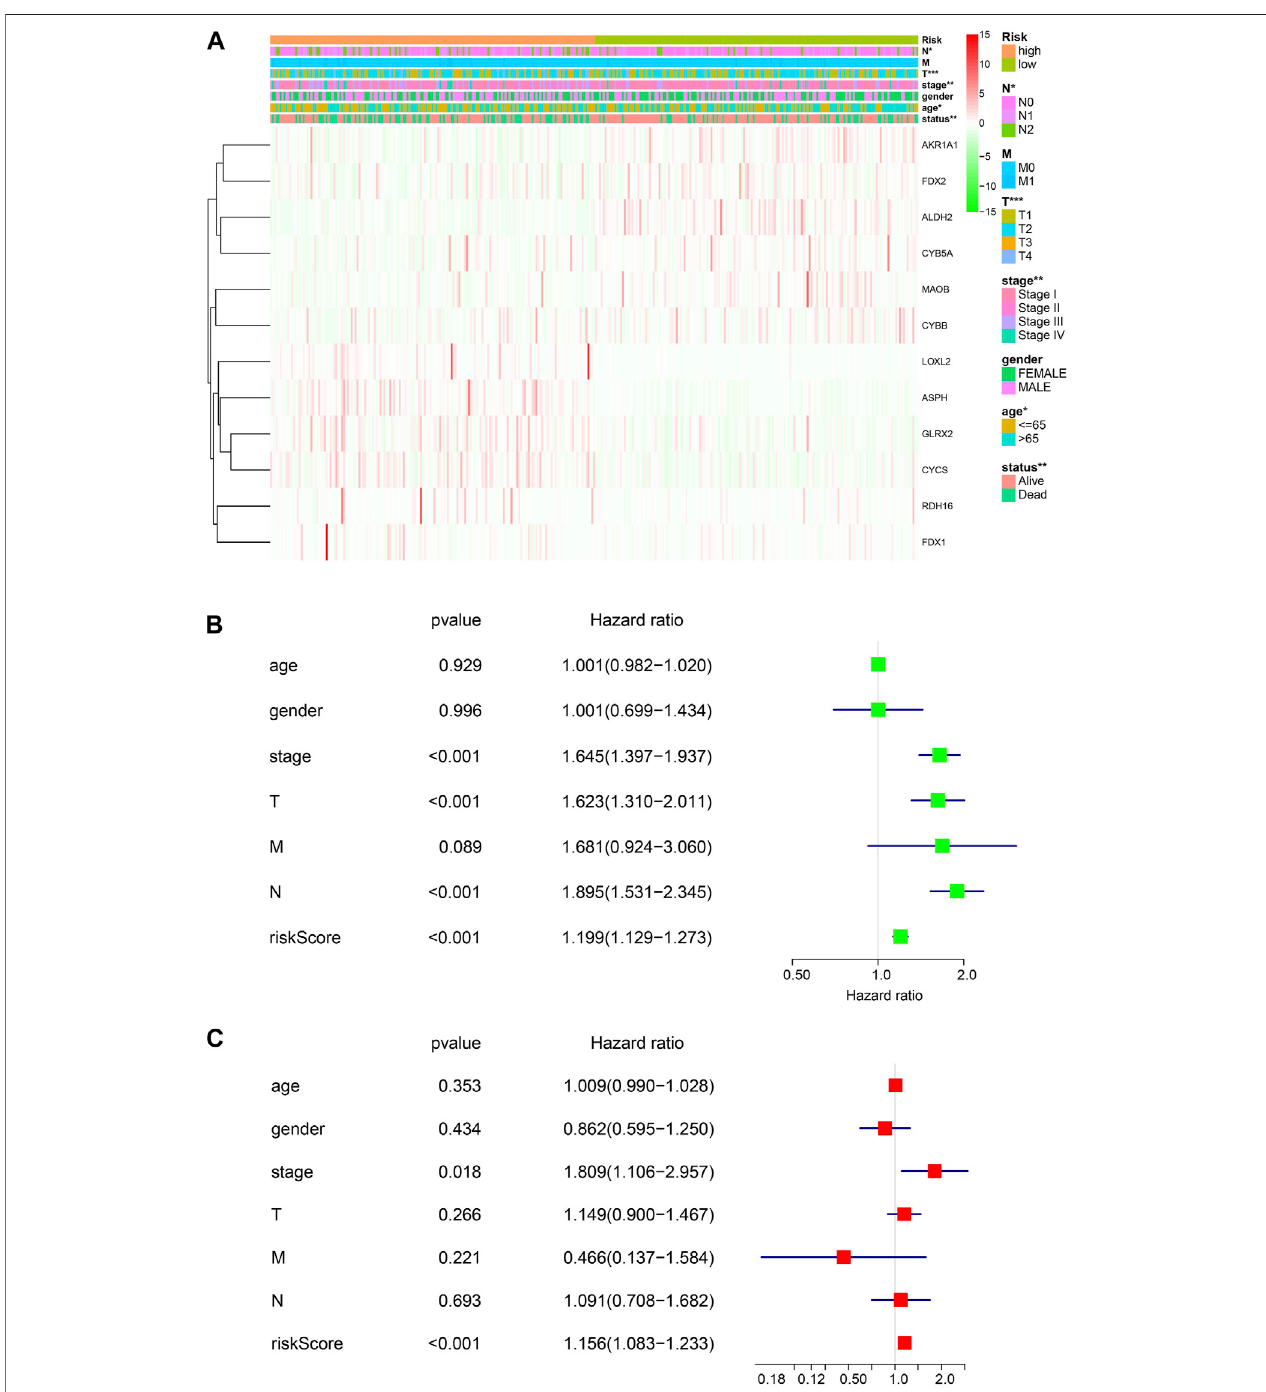
FIGURE 3 | Risk signature of ETC genes in LUAD. (A) . The associations of risk signature and clinicopathological features (T, N, M, tumor stage, gender, age, and the survival status). (B, C) . Univariate and multivariate Cox analyses of the clinicopathological features (age, gender, stage, T, N, and M) and risk signature of overall survival in LUAD